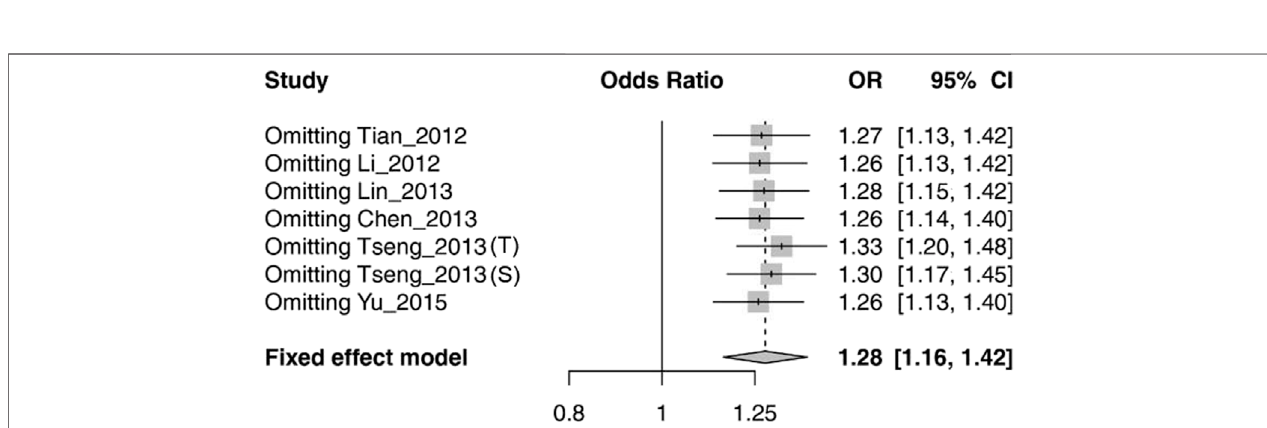
FIGURE 3 | Sensitivity analysis of meta-analysis by omitting every study in turn. Tseng_2013 (T) stands for the Taiwan population in the Tseng_2013 study. Tseng_2013 (S) represents the Singapore population in the Tseng_2013 study. CI (cid:1) Con fi dence Interval.